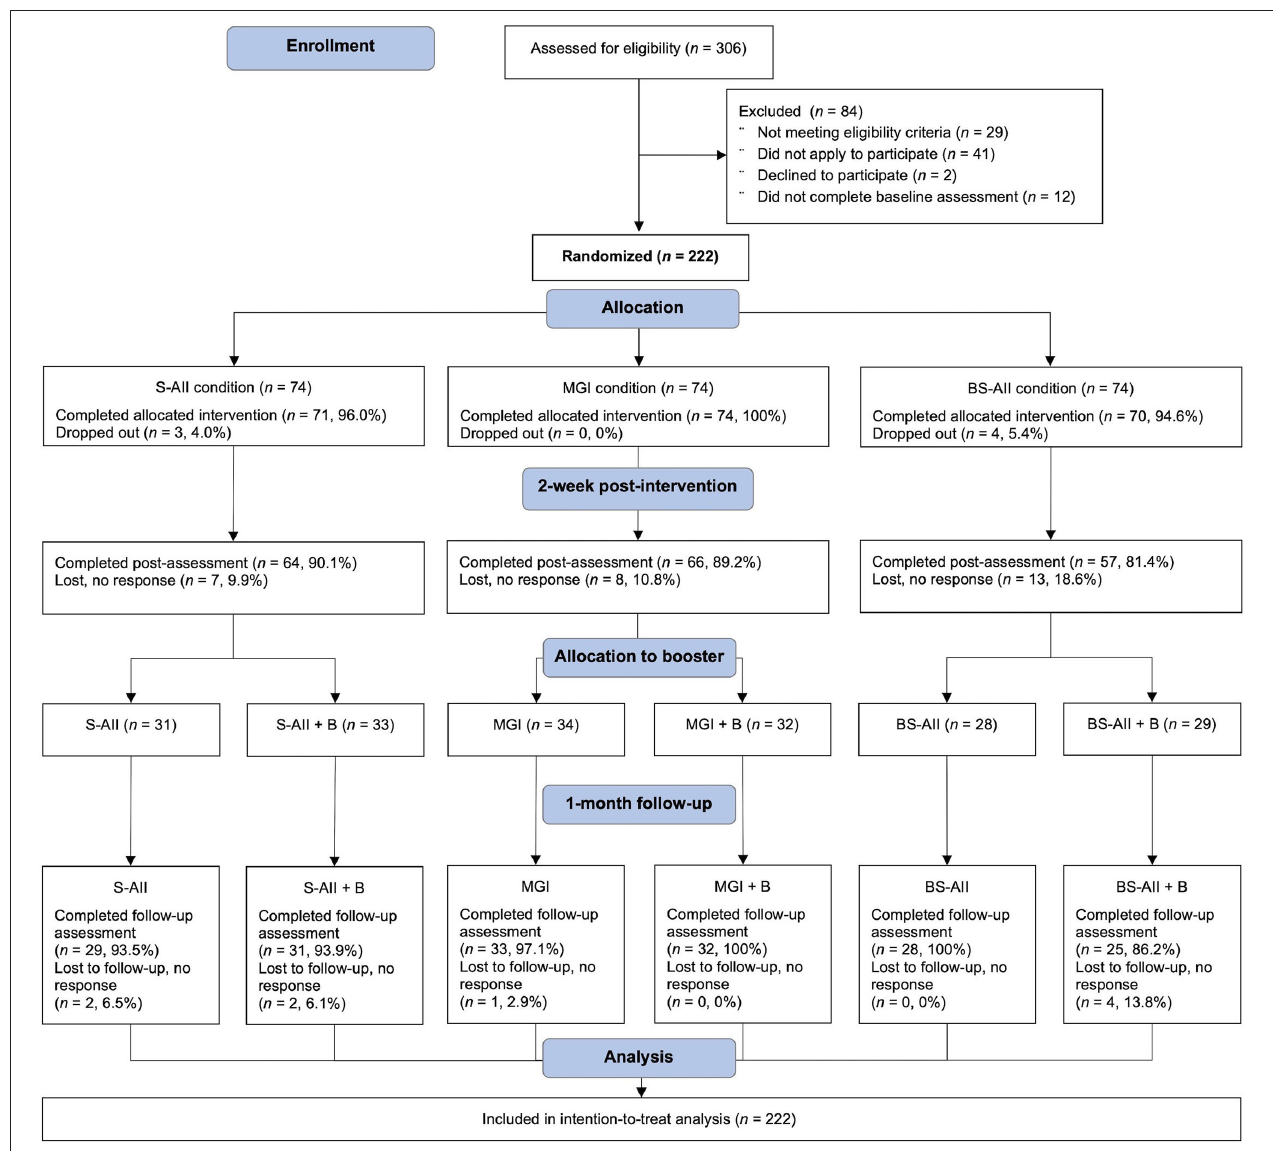
FIGURE 1 | CONSORT flow diagram: enrollment, group randomization, attrition, and data